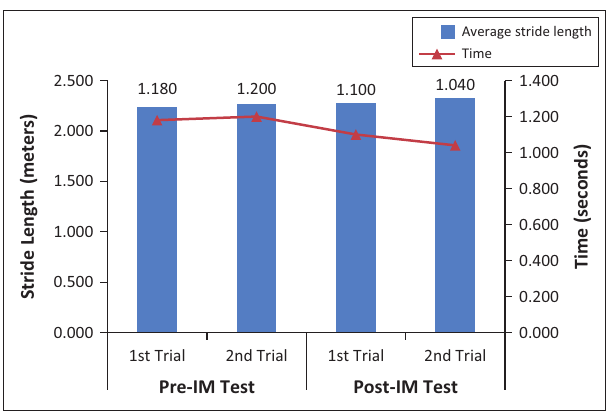
FIGURE 4: Effect of the first two stride lengths within the acceleration phase, on time at 5 m.